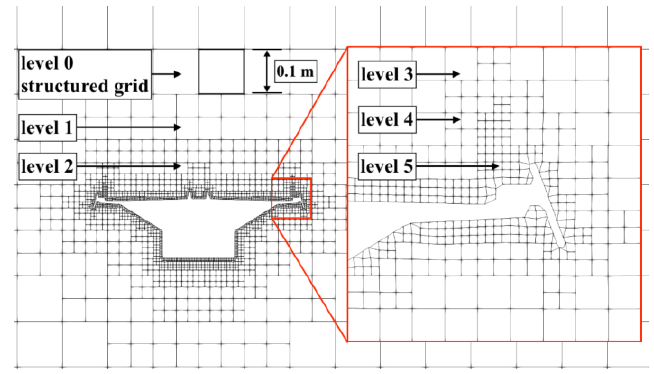
Figure 10. Details of mesh No.1.